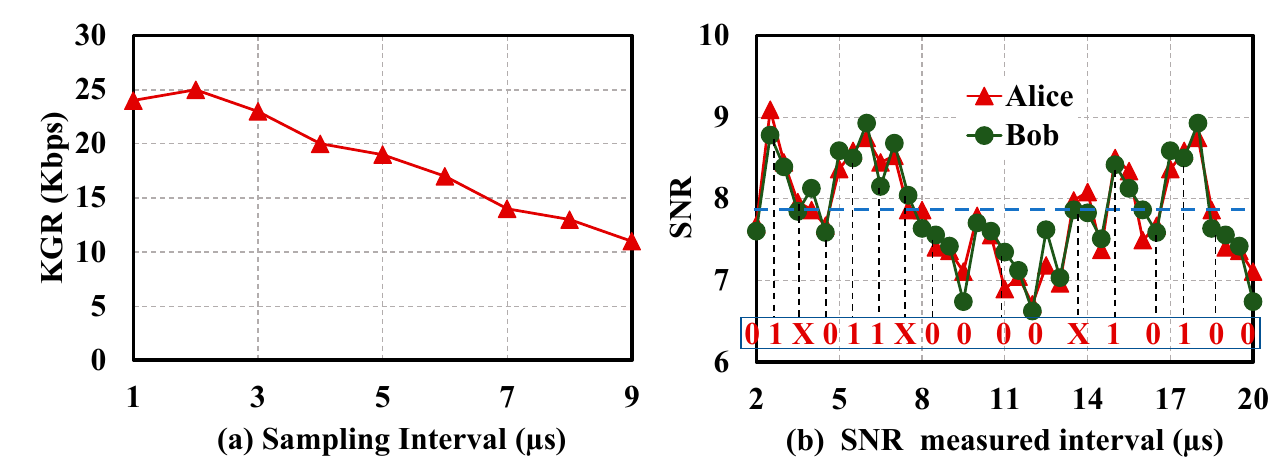
Figure 6. ( a ) KGR change curve and ( b ) key extraction quantization curve .